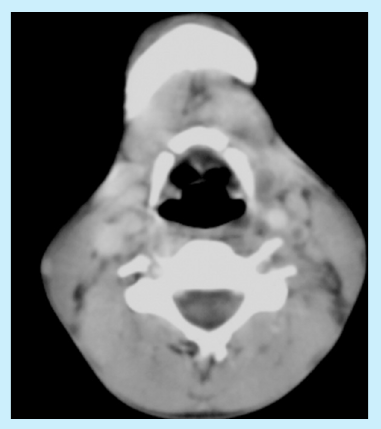
Fig.2. CT scan demonstrates a left IJV hypoattenuating filling defect and a thickened enhancing wall, as well as a small abscess lateral to the hyoid on the ipsilateral side.